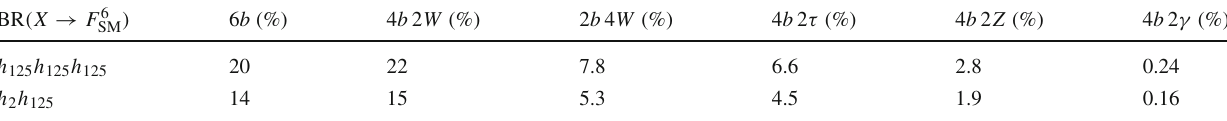
Fig. 10 Branching ratios of the h 125 h 2 state as a function of M 2 for BP3 . Included are a selection of decay modes into SM particles as well as the cascade decay to h 125 h 125 h